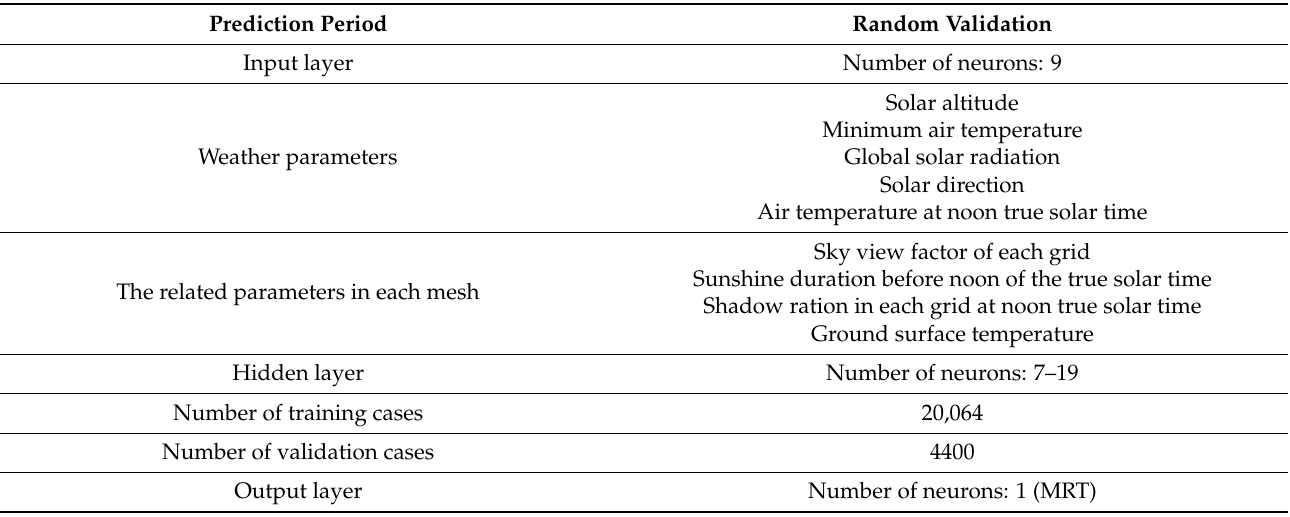
Table 3. ANN model